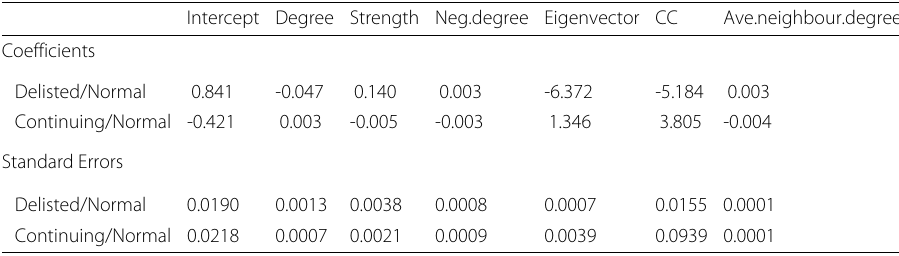
Table 4 Estimated coefficients and corresponding standard errors Intercept Degree Strength Neg.degree Eigenvector CC Ave.neighbour.degree